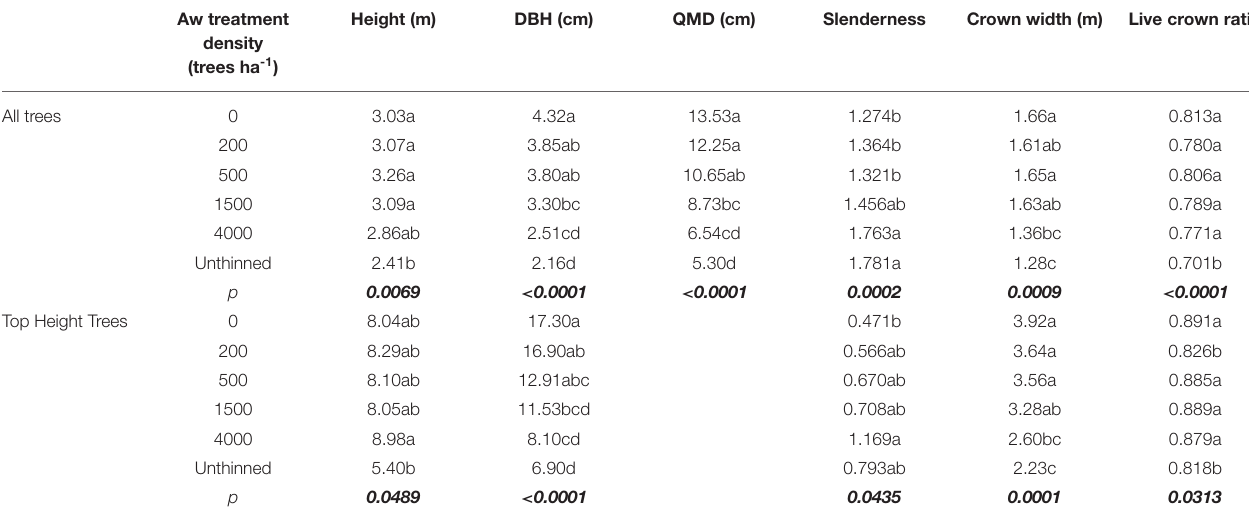
TABLE 3 | Treatment effects on spruce at age